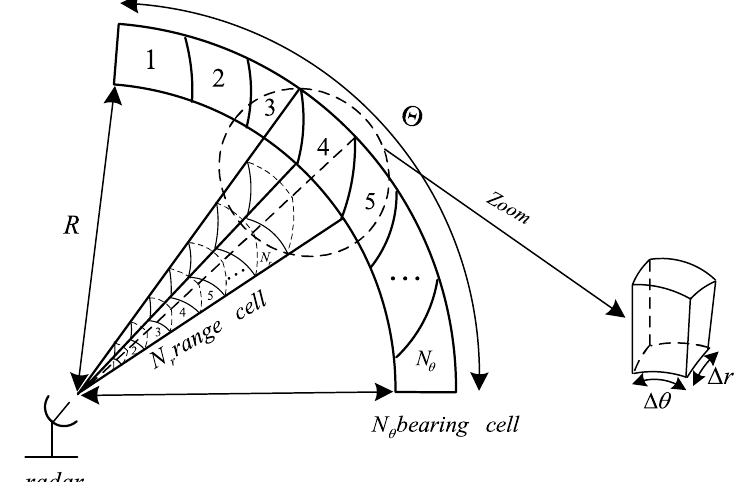
Fig. 1 Radar surveillance region